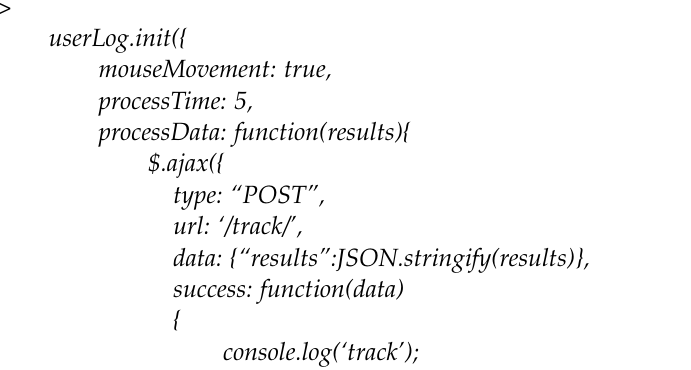
Figure A2. ANN MLP graph model.